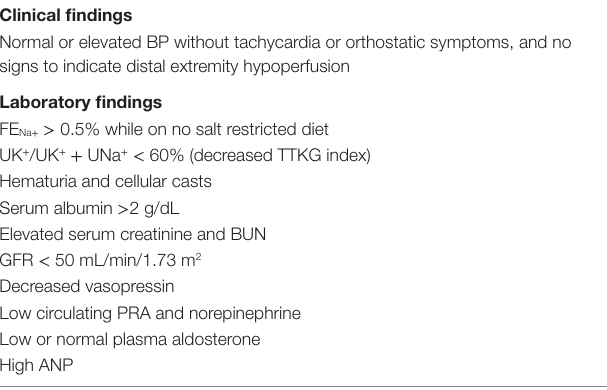
TABLe 3 | Mechanism of edema formation in nephrotic syndrome: